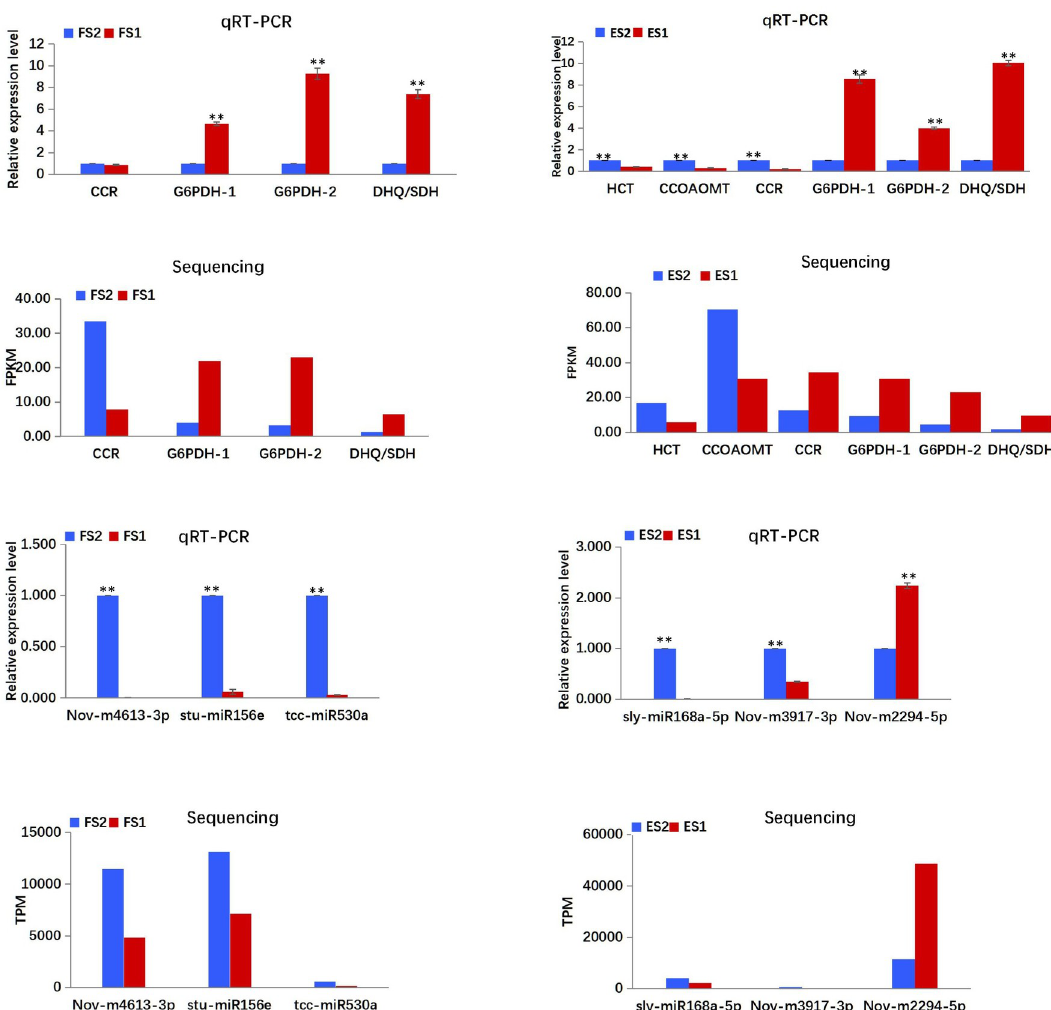
Fig 9. Expression patterns of mRNAs and miRNAs determined by qRT-PCR. Expression levels of mRNAs and miRNAs were normalized according to the level of β -actin in qRT-PCRs. Three biological replicates were performed for each mRNA and miRNA. T-TEST was employed to analyse the data. The data were presented as the mean ± SD. �� P < 0.01.